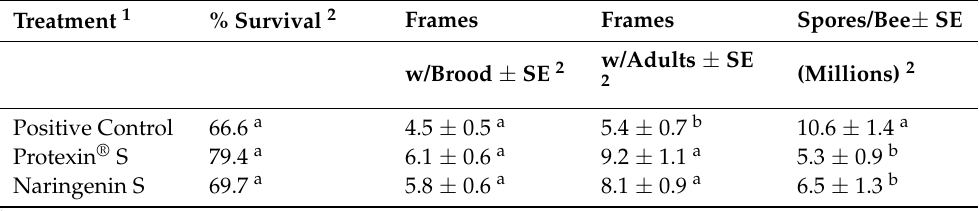
Table 10. Effect of fall 2018 treatments on percent overwinter survival, number of frames with brood or adult bees, and number of N. ceranae spores per bee in the spring 2019 for colonies treated with the prebiotic naringenin or probiotic Protexin ® . Means are from 33 colonies for positive control and naringenin S and 34 colonies for Protexin ®